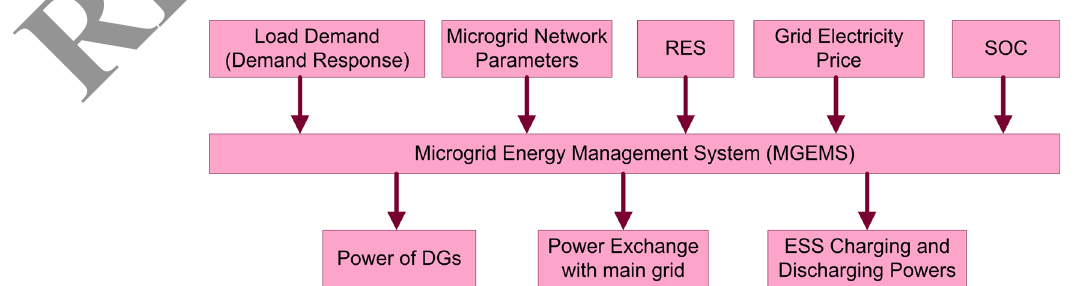
Fig. 1 Microgrid energy management